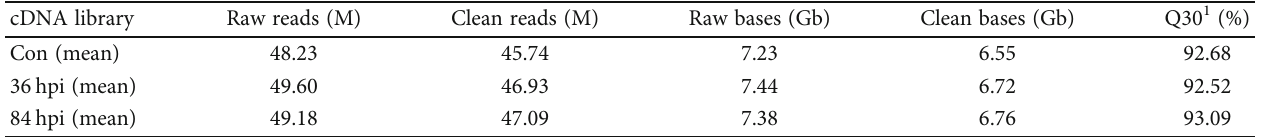
Note: 1 Q30: percentage of bases with a Phred value > 30 . (mean) indicates the mean of three biological